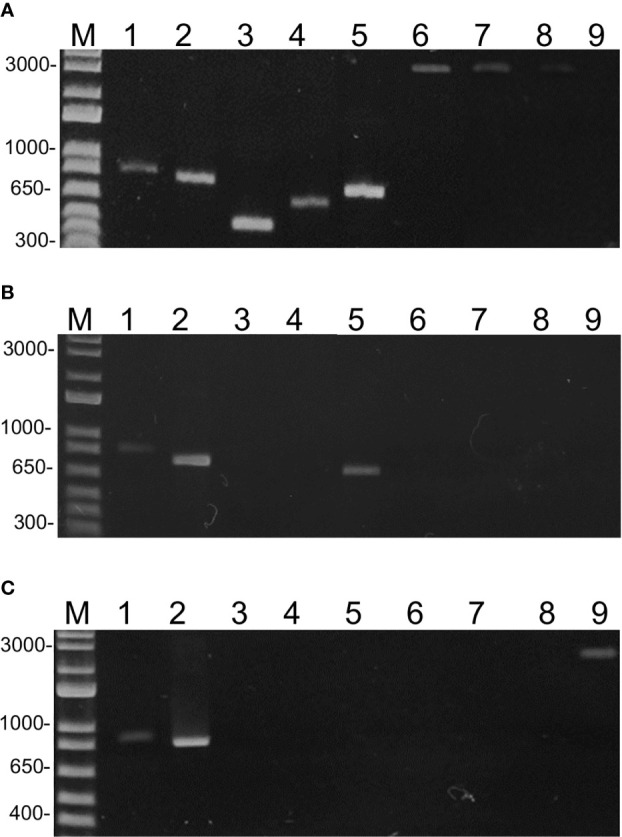
Electrophoretic analysis of PCR amplicons on 1% agarose gel from pooled RCA samples of the G1 (A), G2 (B), and G3 (C) groups. PCR was performed using specific primers (Supplementary Table 1) for ToSRV (1), ToMoLCV (2), TGVV (3), ToCMoV (4), SiMMV (5), ToALCV (6), ToRMV (7), Bego1 (8), and Bego2 (9). M = 1 kb plus DNA ladder (Thermo Fisher Scientific).